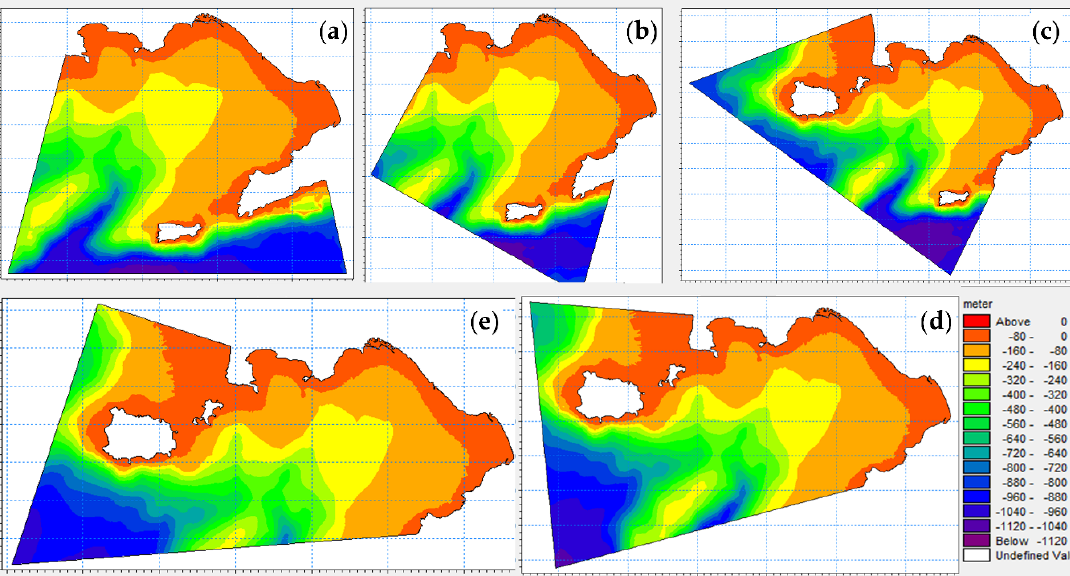
Figure 9. Bathymetry implemented for each boundary orientation: ( a ) model M180°; ( b ) model M220°; ( c ) model M240°; ( d ) model M260°; ( e ) model M280°.